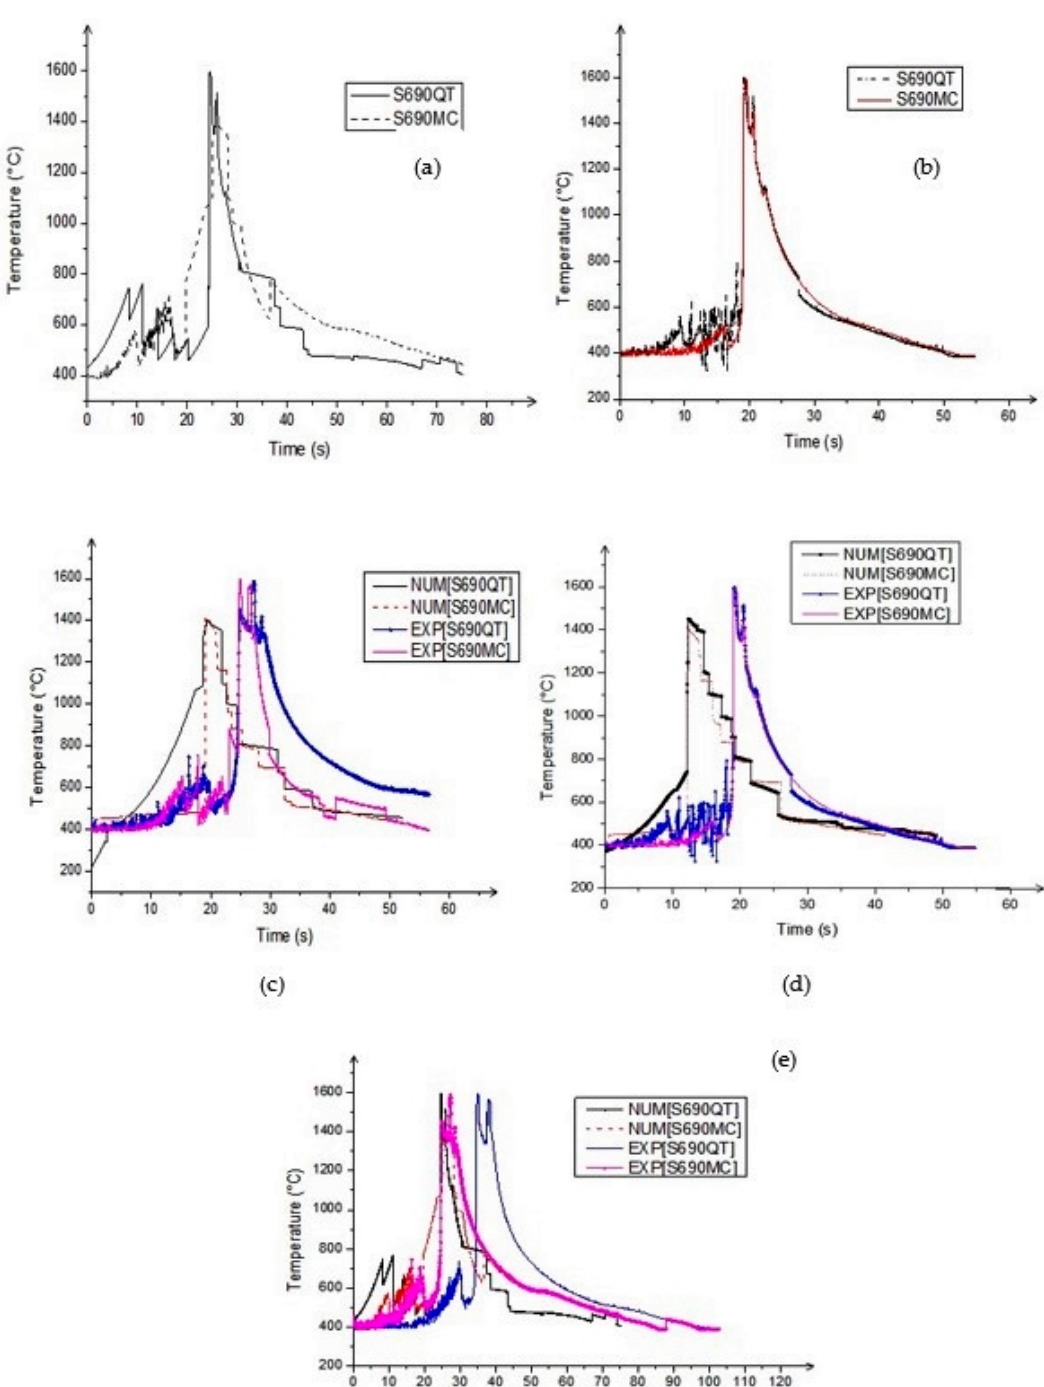
Figure 7. Cooling time results in the weld joint: experimental values using ( a ) 10 kJ/cm of heat input, and ( b ) 14 kJ/cm of heat input. Comparison between numerical and experimental values using ( c ) 10 kJ/cm of heat input, ( d ) 14 kJ/cm of heat input, and ( e ) 17 kJ/cm of heat input.